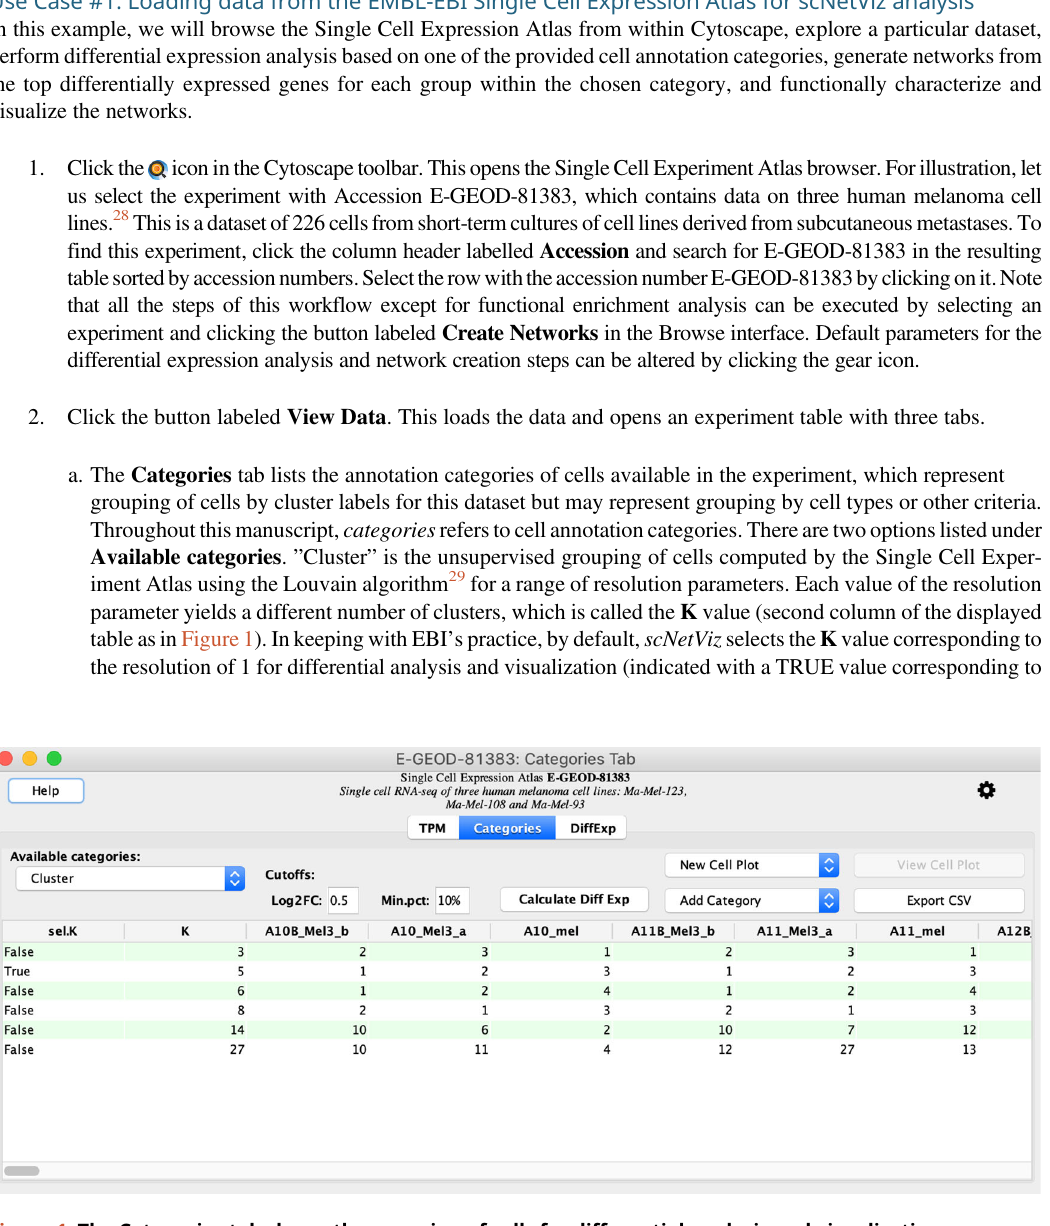
Figure 1. The Categories tab shows the grouping of cells for differential analysis and visualization purposes. The menu labeled New Cell Plot contains options for generating UMAP and t-SNE plots. Note that these results are for data from the Single Cell Expression Atlas release 15 (March,